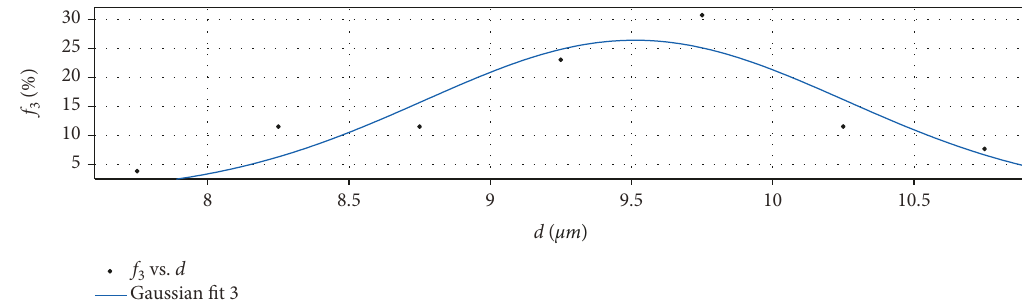
Figure 11: Data fi tting result of fi ber diameter distribution.